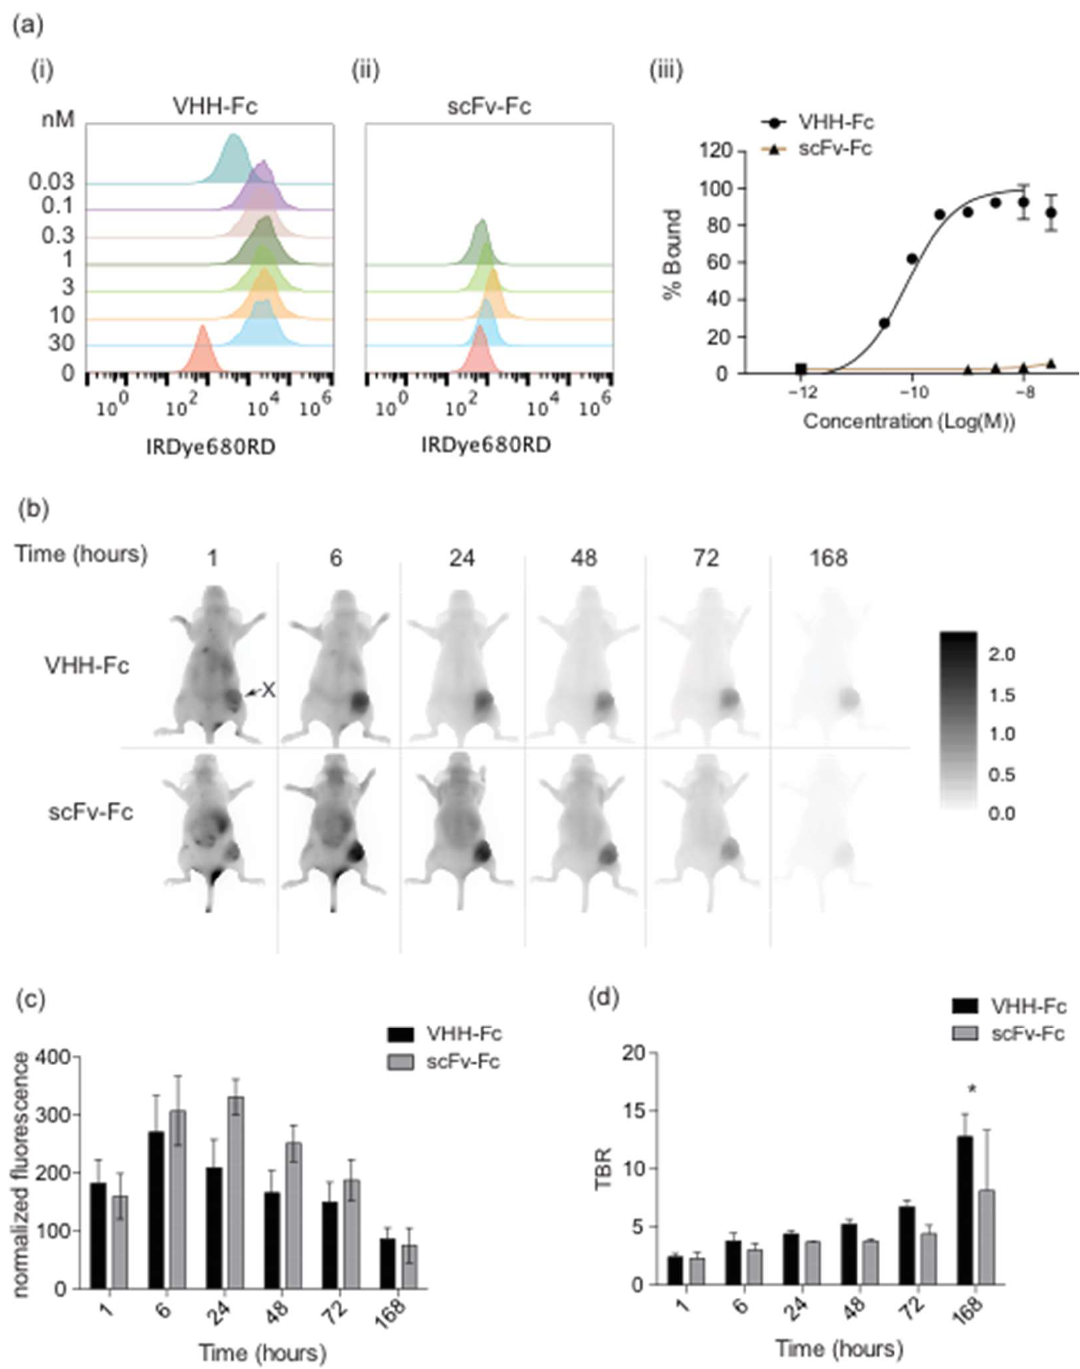
Figure 2. Fc-containing imaging probe binding to FaDu cell lines and xenografts. ( a ) ( i , ii ) Histograms and ( iii ) binding curves of VHH-Fc imaging probe, with a VHH domain that binds FaDu cells and scFv-Fc, with an scFv that binds MBP were tested for binding to FaDu cells. ( b ) Fluorescence imaging of the VHH-Fc (top) and scFv-Fc (bottom) probes in CD-1 nude mice bearing FaDu xenografts over time. ( c ) Normalized fluorescence and ( d ) tumor-to-background (TBR) of mouse imaging shown in ( b ). Error bars shown are representative of the standard error of the mean from at least three independent mice. * represents the p -value ≤ 0.05. X identifies the location of the xenograft.